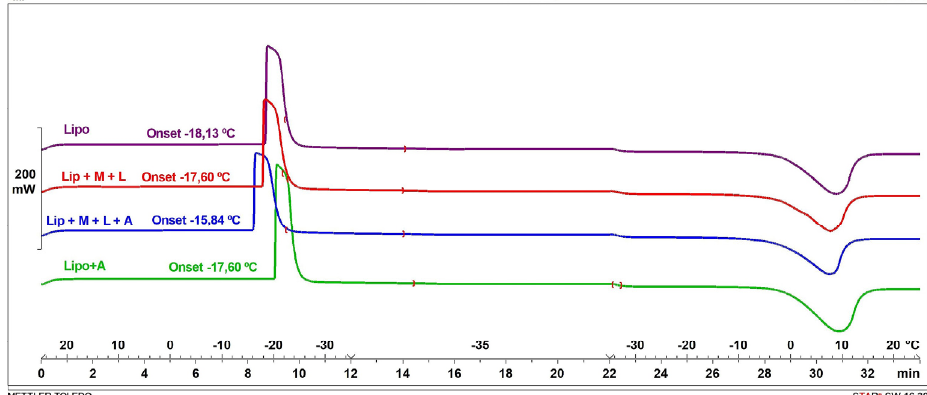
Figure 4. Thermograms of liposome samples without additives and liposomes in mixtures containing different additives (L: lactose; M: mannitol; A: alginate).